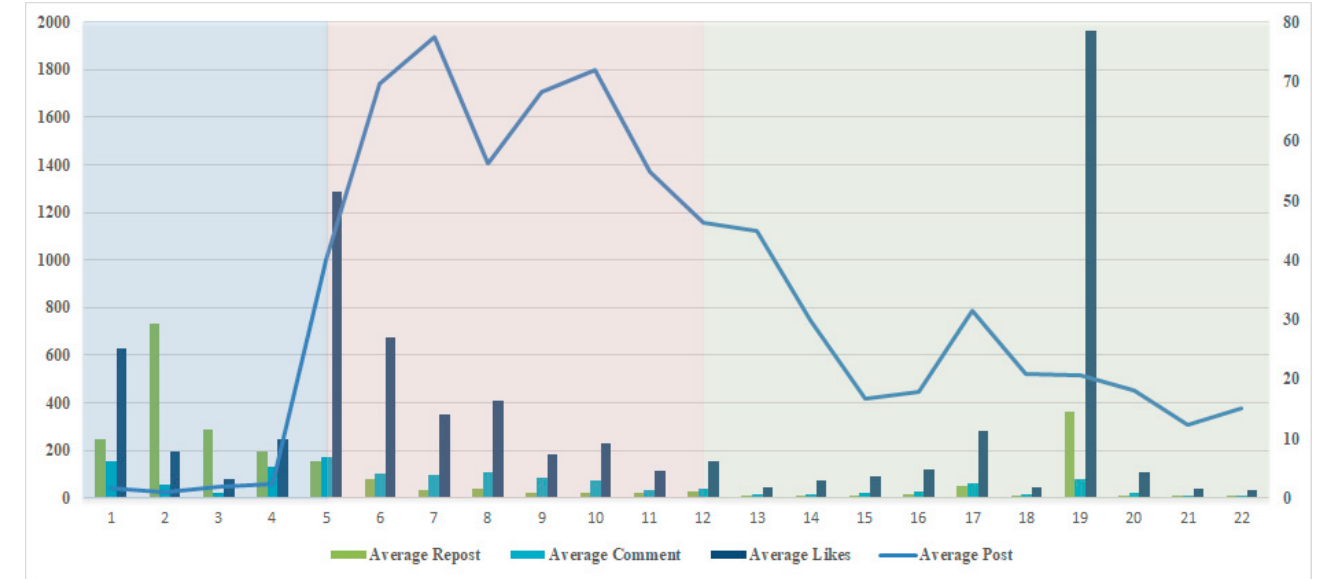
Figure 1. Average count of each days’ post/repost/comment/likes during 22 groups. Table 2. The divide of 22 groups of date.